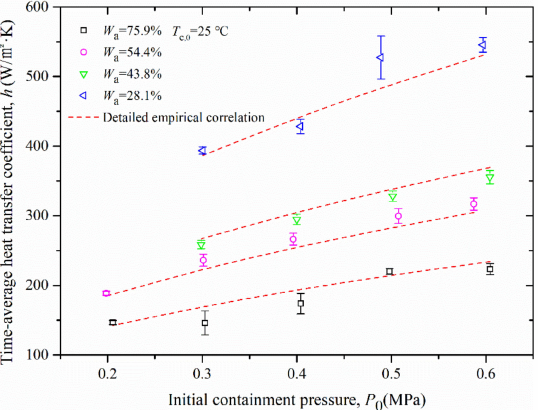
Figure 6. Predicted values of current empirical correlation under different air mass